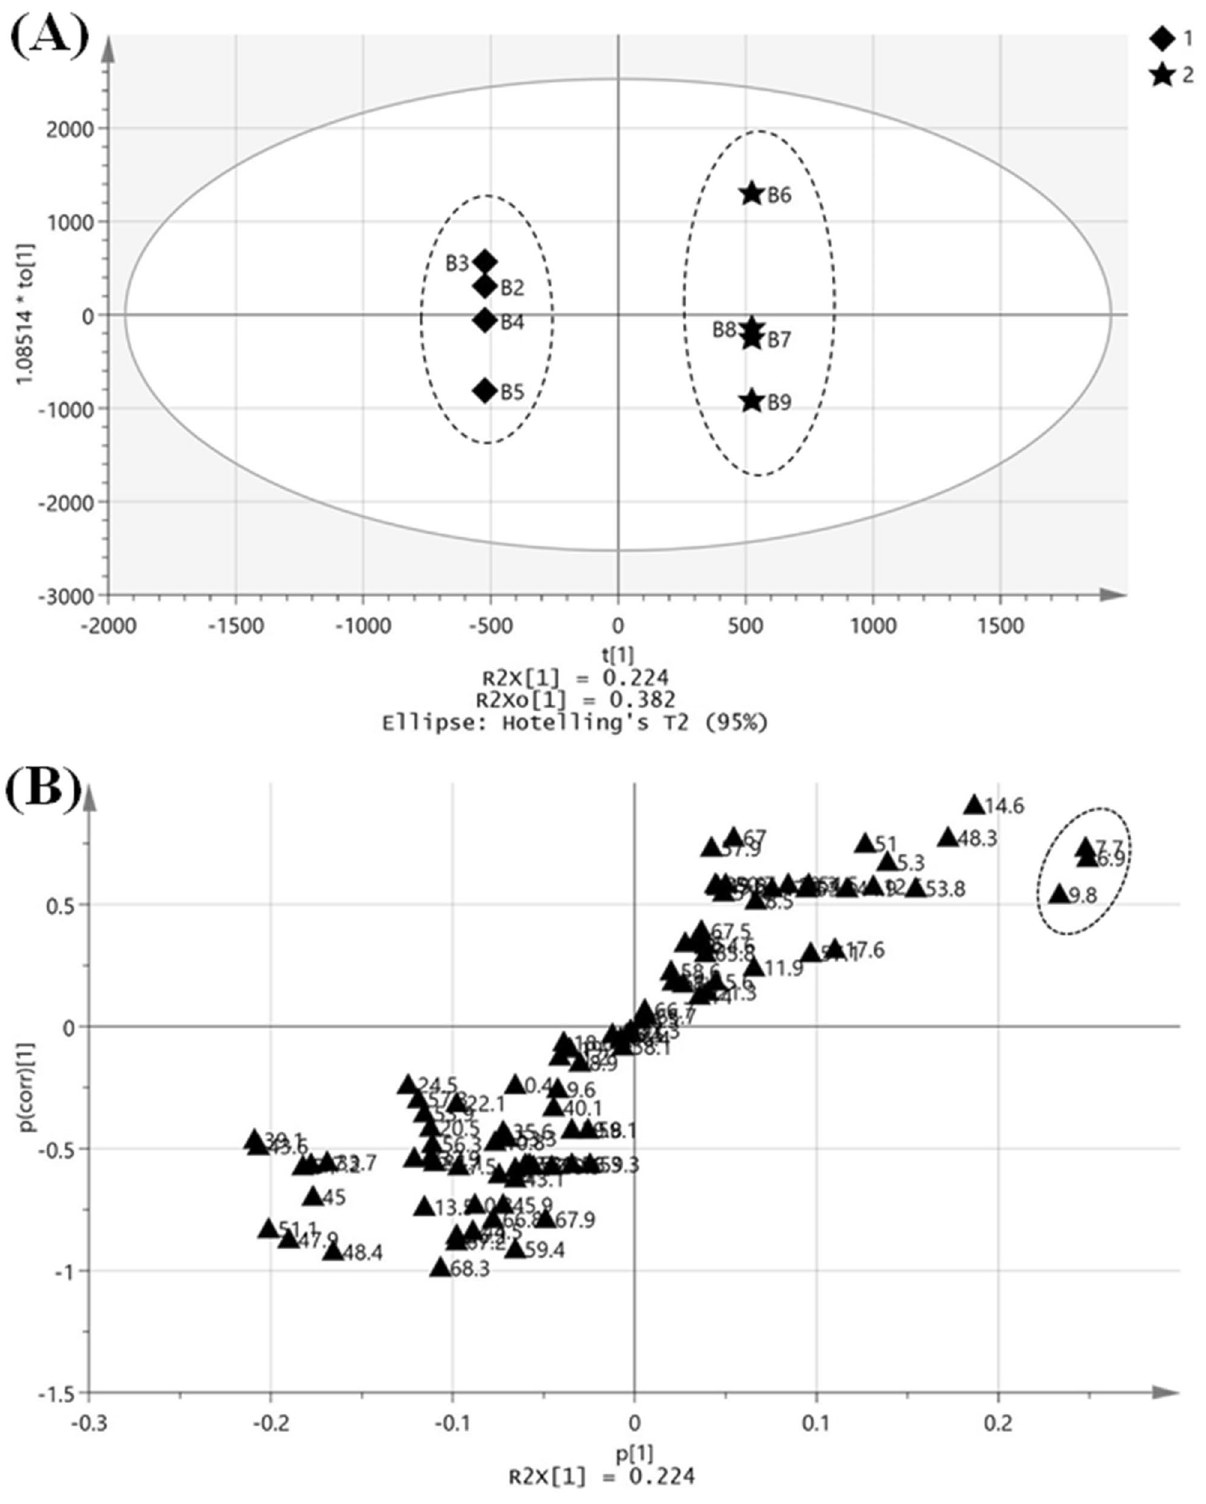
Figure 4. Orthogonal partial least-squares to latent structures-discrimination analysis (OPLS-DA) of characterizing components related to anti-wrinkle activity. ( A ) Score plot of OPLS-DA from UPLC–PDA chromatogram data of DW-GBEs and MRW-GBEs (1. Diamond represents DW-GBEs; 2. The 5-pointed star represents MRW-GBEs). ( B ) S-plot of OPLS-DA from UPLC–PDA chromatogram data of DW-GBEs and MRW-GBEs (Markers in the circle were the selected differential compounds of which the VIP > 2). All the plots were drawn by SIMCA-P + (Version